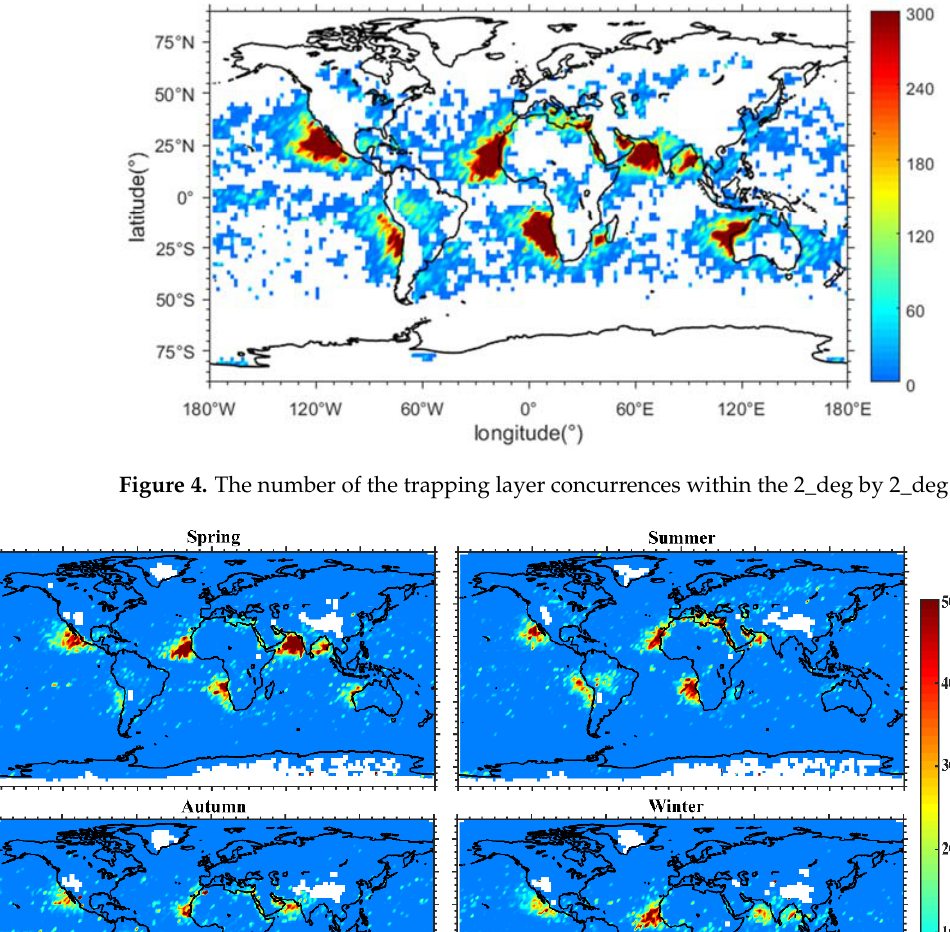
represent that there is no radio occultation event. no radio occultation